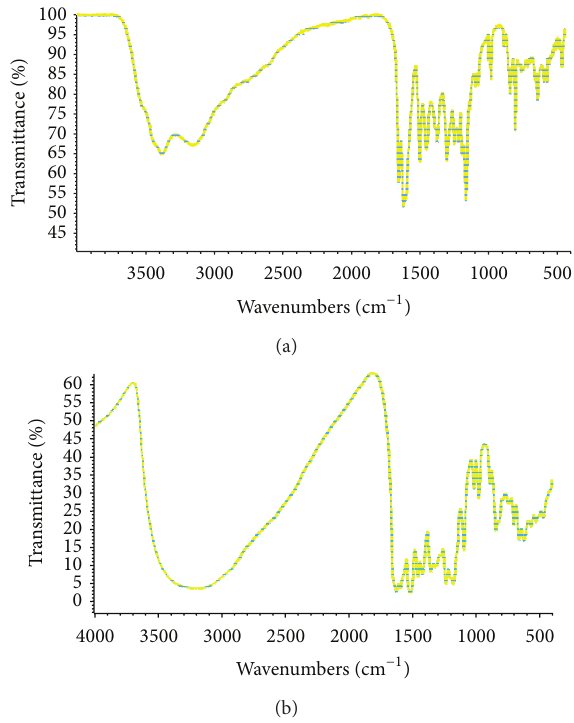
Figure 3: IR spectra of (a) morin and (b) Cr(III)-morin complex illustrating the major changes observed between